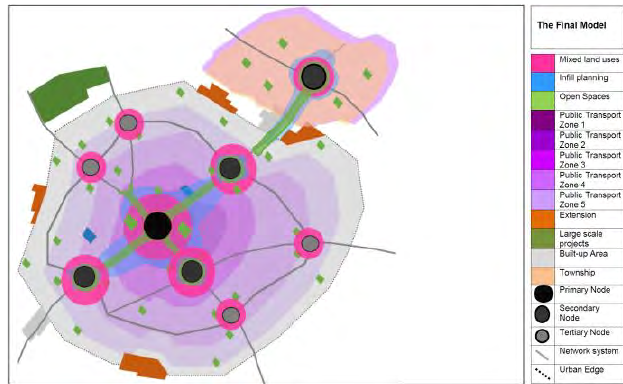
Figure 3: Urban resilience and efficiency model Source: Richter,